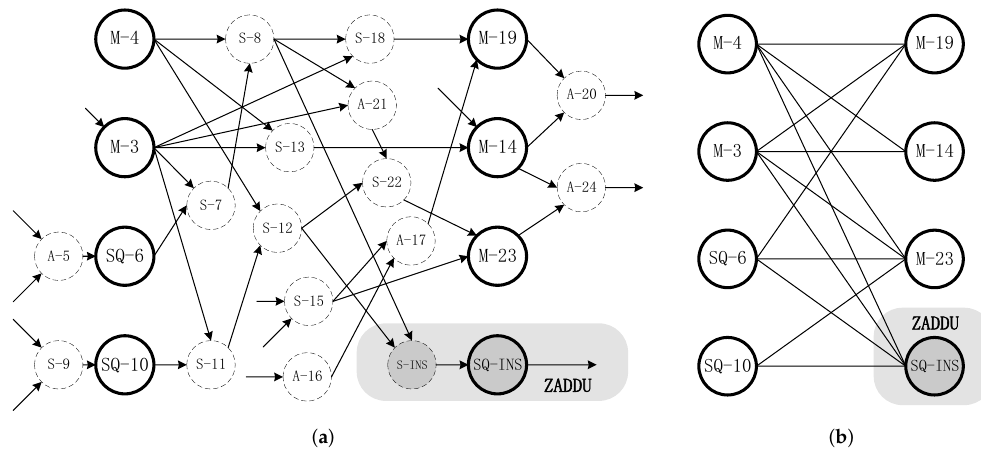
Figure 4. Directed acyclic graph of improved ZADDC. ( a ) Full ops. ( b ) A and S omitted.